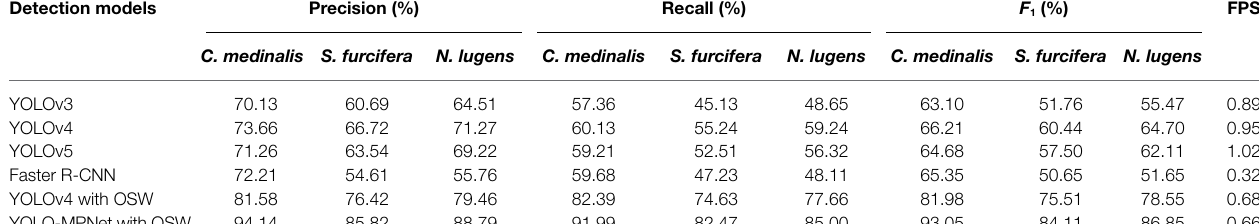
TABLE 2 | The detection results of different models for migratory pests. Detection